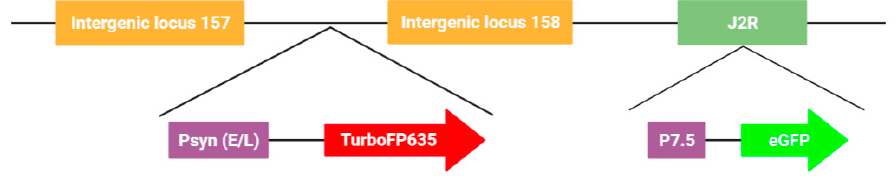
Figure 2. Schematic representation of recombinant vaccinia virus L1c-Ig-Turbo-TK-eGFP.